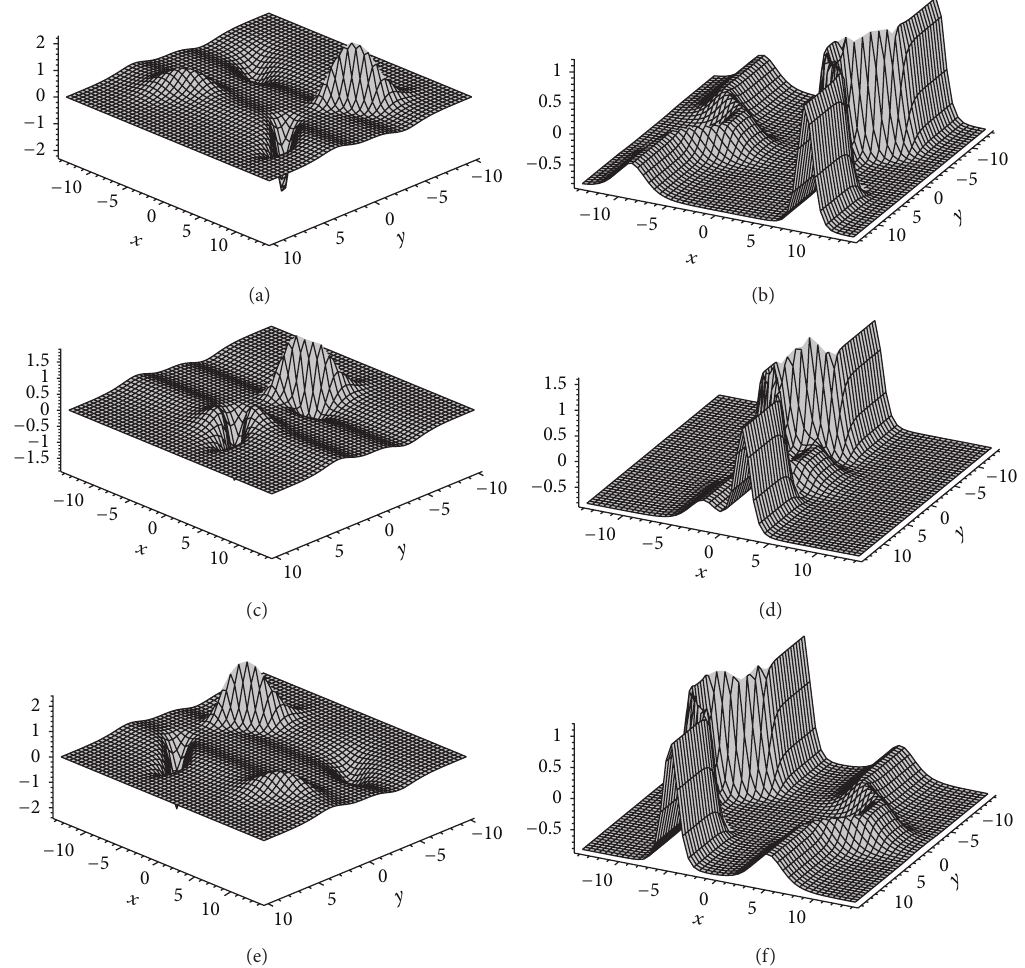
Figure 3: The plots of 𝑢 1 , V 1 in Family 1 with parameters 𝐹 1 (𝑡) = 𝑡 , 𝐹 2 (𝑦) = 4 sech (0.1𝑦 2 ) , 𝐶 1 = 0.5 , 𝐶 3 = 1 , 𝐶 5 = −1 , 𝐶 2 = 𝐶 4 = 𝐶 6 = 0 , 𝜙 = tanh, and 𝜓 = tanh at ((a) and (b)) 𝑡 = −9 , ((c) and (d)) 𝑡 = −2 , and ((e) and (f)) 𝑡 = 5 .